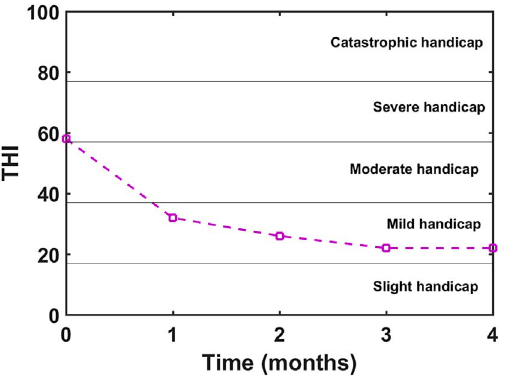
Figure 10. THI time progress of participant #1 along treatment.